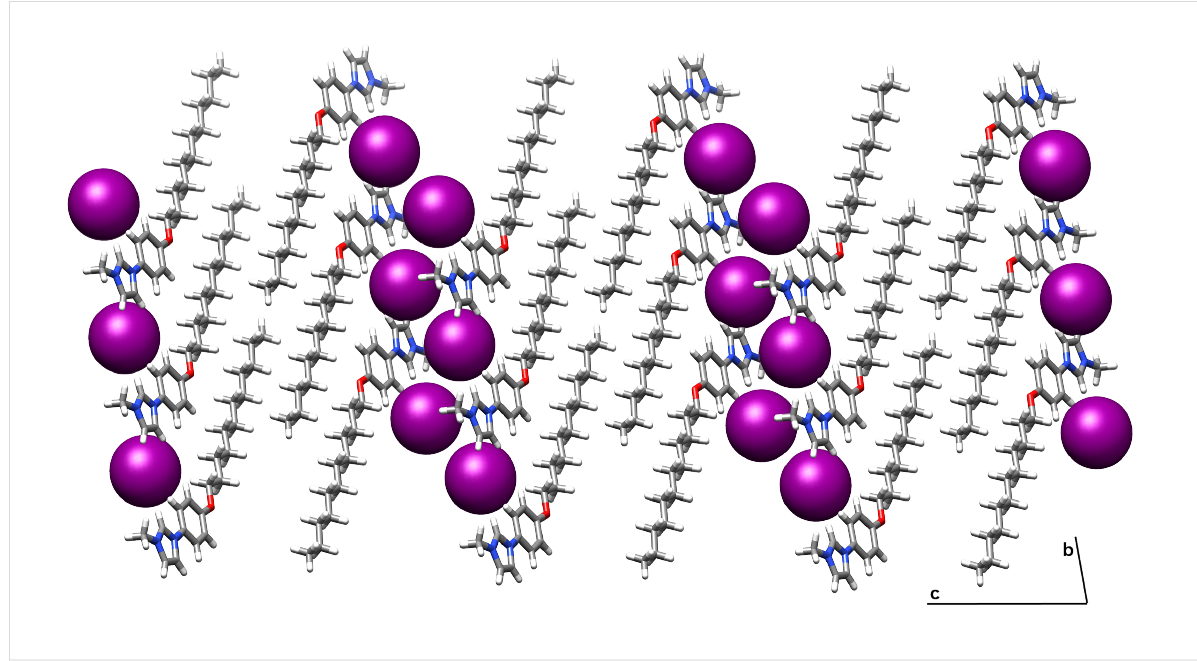
Figure 2: Packing diagram of compound 1a in projection in the (b,c) lattice plane. Large spheres represent the iodine atoms.